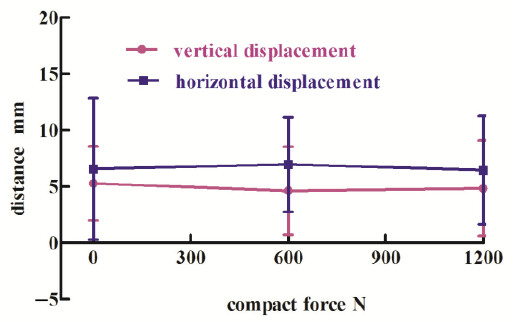
Figure 18. The displacements of seeds after soil compacting for the variety of compacting forces (0 N, 600 N, 1200 N).